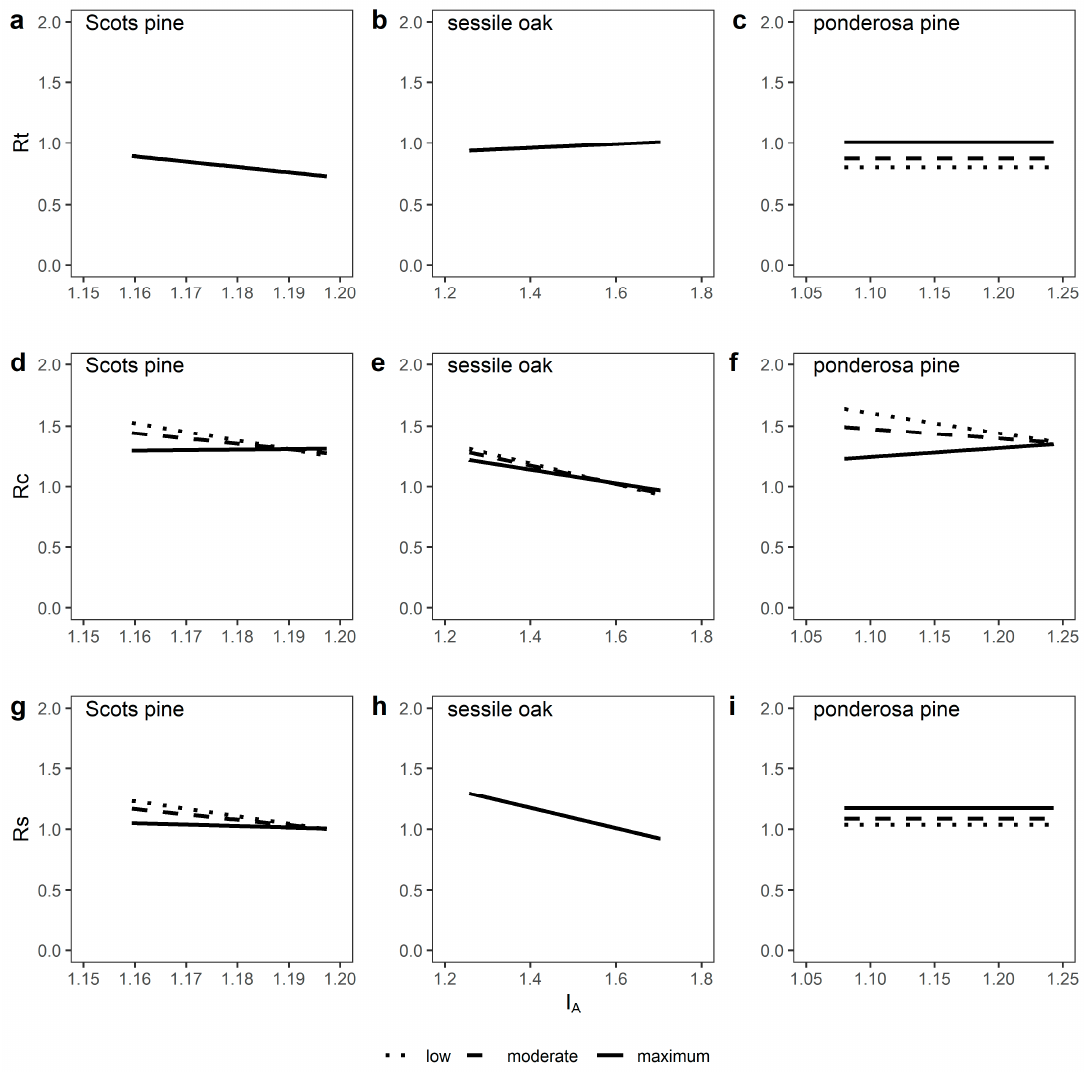
Figure 3. E ff ect of site water availability ( I A ) on the drought responses of Scots pine ( Rt ( a ), Rc ( d ), Figure 3. Effect of site water availability ( (cid:1835) (cid:3002) ) on the drought responses of Scots pine ( (cid:1844)(cid:1872) ( a ), (cid:1844)(cid:1855) ( d ), Rs ( g ) ), sessile oak ( Rt ( b ), Rc ( e ), Rs ( h )) and ponderosa pine ( Rt ( c ), Rc ( f ), Rs ( i )) under di ff erent stand (cid:1844)(cid:1871) ((cid:1807)) ), sessile oak ( (cid:1844)(cid:1872) ( b ), (cid:1844)(cid:1855) ( e ), (cid:1844)(cid:1871) ( h )) and ponderosa pine ( (cid:1844)(cid:1872) ( c ), (cid:1844)(cid:1855) ( f ), (cid:1844)(cid:1871) ( i )) under density levels (low, moderate, maximum). Lines represent the fixed e ff ect terms from Equation (8). different stand density levels (low, moderate, maximum). Lines represent the fixed effect terms from Explanatory variables other than I A were set at the respective means of each stand density level as Equation (8). Explanatory variables other than (cid:1835) (cid:3002) were set at the respective means of each stand obtained from the density level as obtained from the data.